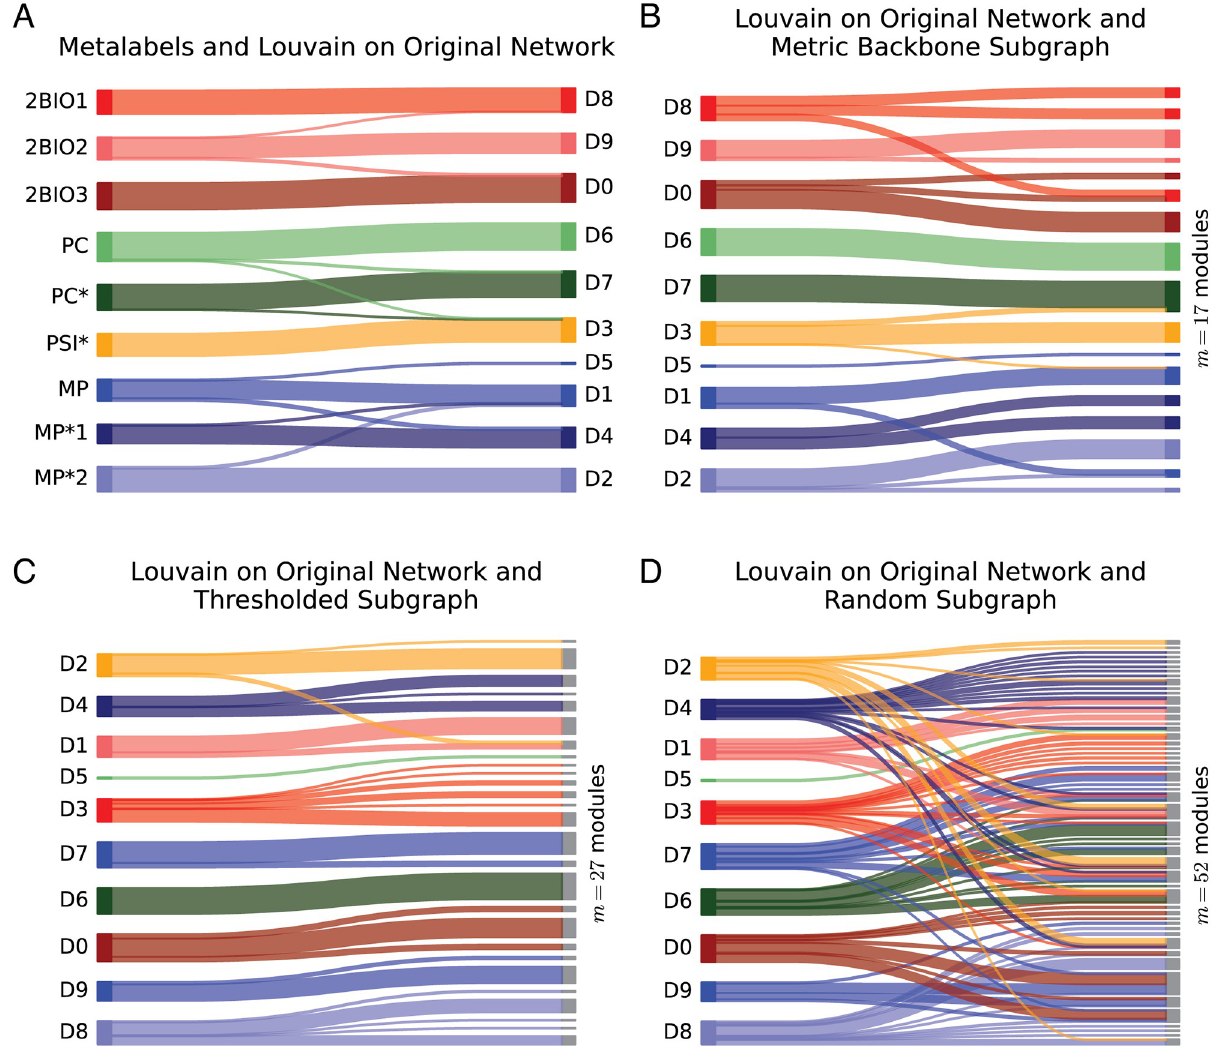
Fig 2. Community structure comparison for the French high school (Fr-HS) dataset using Sankey plots. ( A ) Comparison of metalabels—student attribution to their classes—with modules detected on the original graph. ( B ) Comparison of the modules detected on the original graph with those detected on its metric backbone subgraph. ( C ) Comparison of the modules detected on the original graph with those detected on the threshold subgraph of same size as the metric backbone. ( D ) Comparison of the modules detected on the original graph with those detected on a random subgraph of the same size as the metric backbone. Metalabel module colors assigned to student specialization and classes as in Fig 1A–1C. Modules computed using the Louvain algorithm